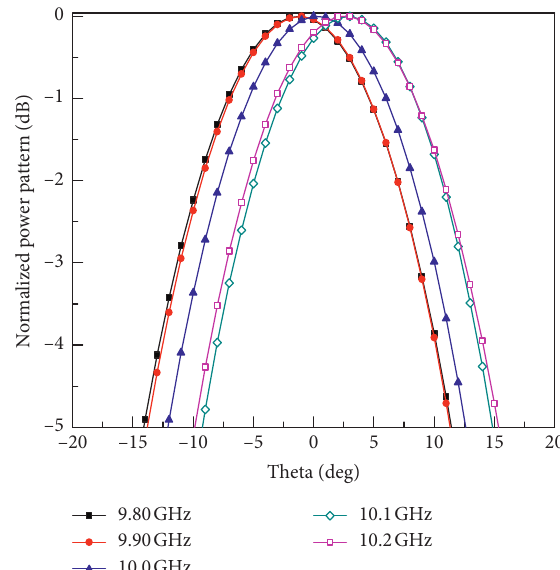
Figure 15: Main beam positioning vs.